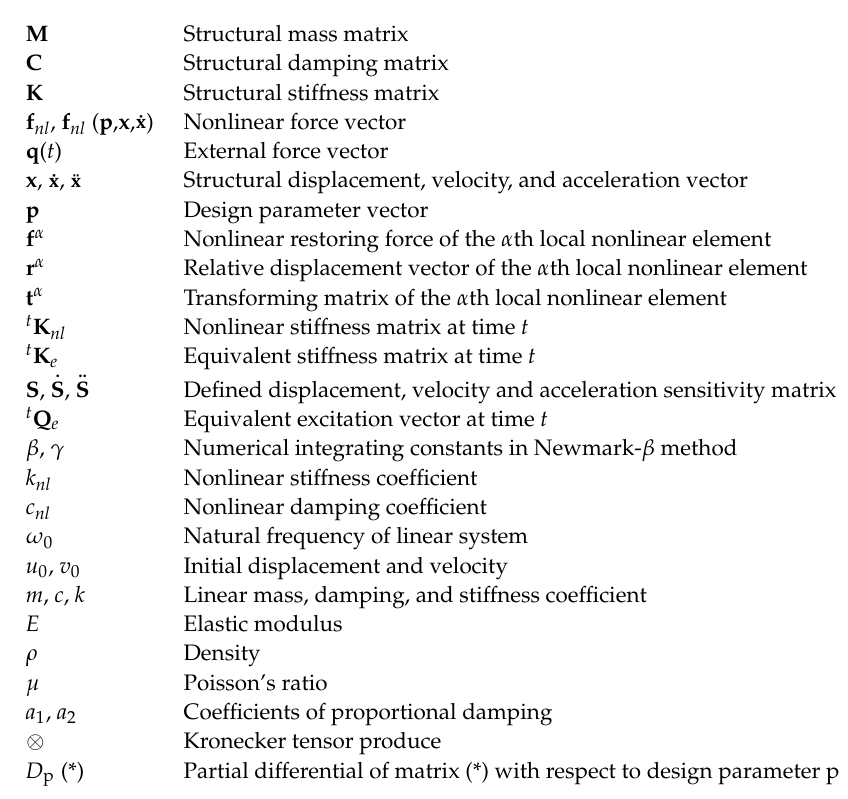
Algorithm 1. Pseudo-code for initial transient response sensitivity